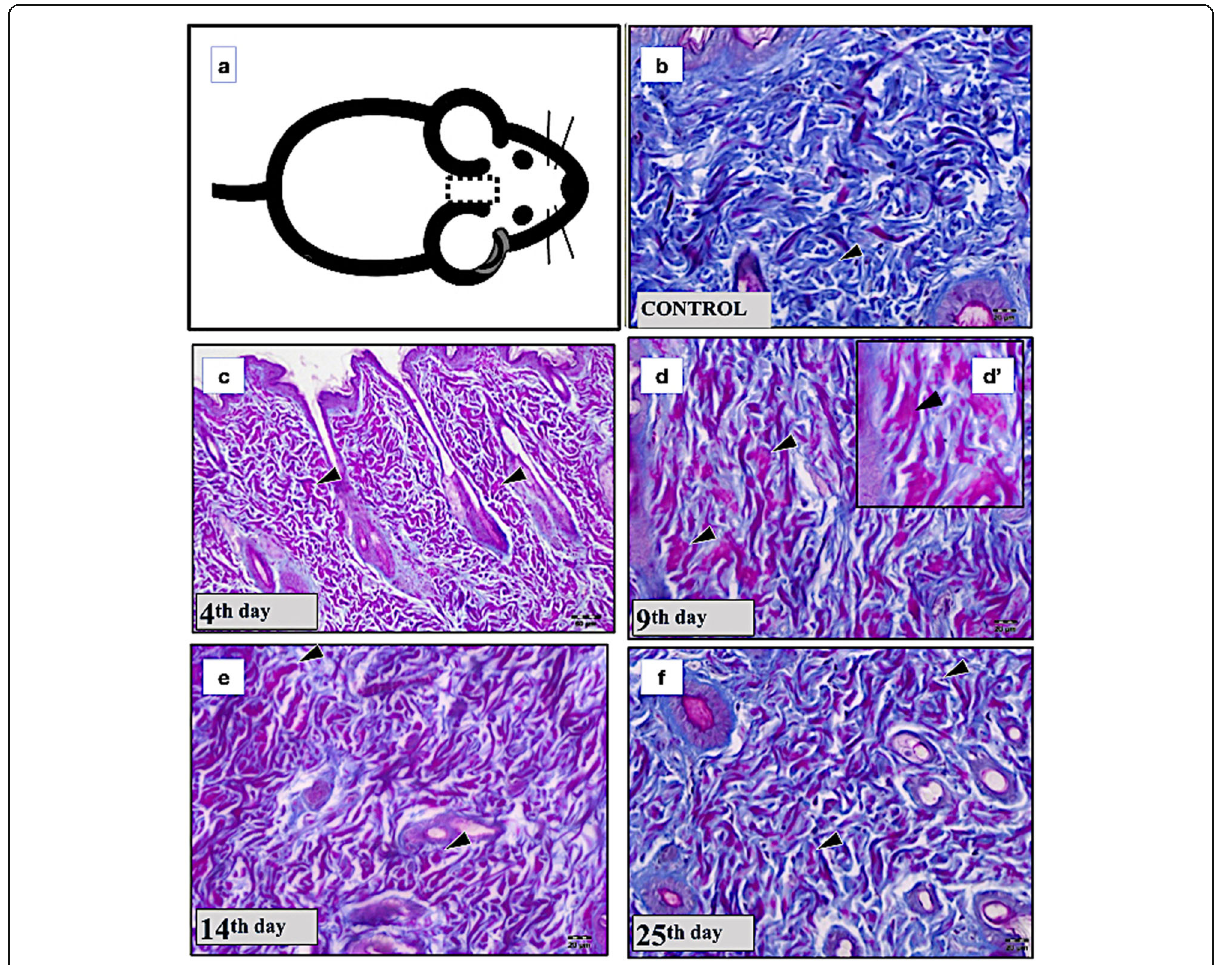
Fig. 2 Representative images of the dermis layer of skin obtained from Masson trichrome staining for each time point assessed after x-ray irradiation. Scheme of the calvaria region in which the skin was evaluated ( a ). Control ( b ), day 4 ( c ), day 9 ( d ), detail from d ( d ’ ), day 14 ( e ), and day 25 ( f ). Note the amorphous morphology of the collagen fibers produced by the x-ray irradiation in d ’